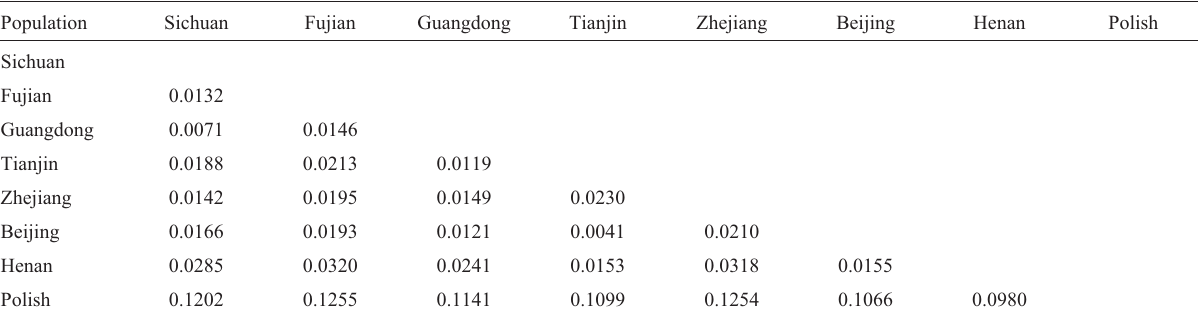
Table 1 - Genetic distances of 8 populations using UPGMA software. Population Sichuan